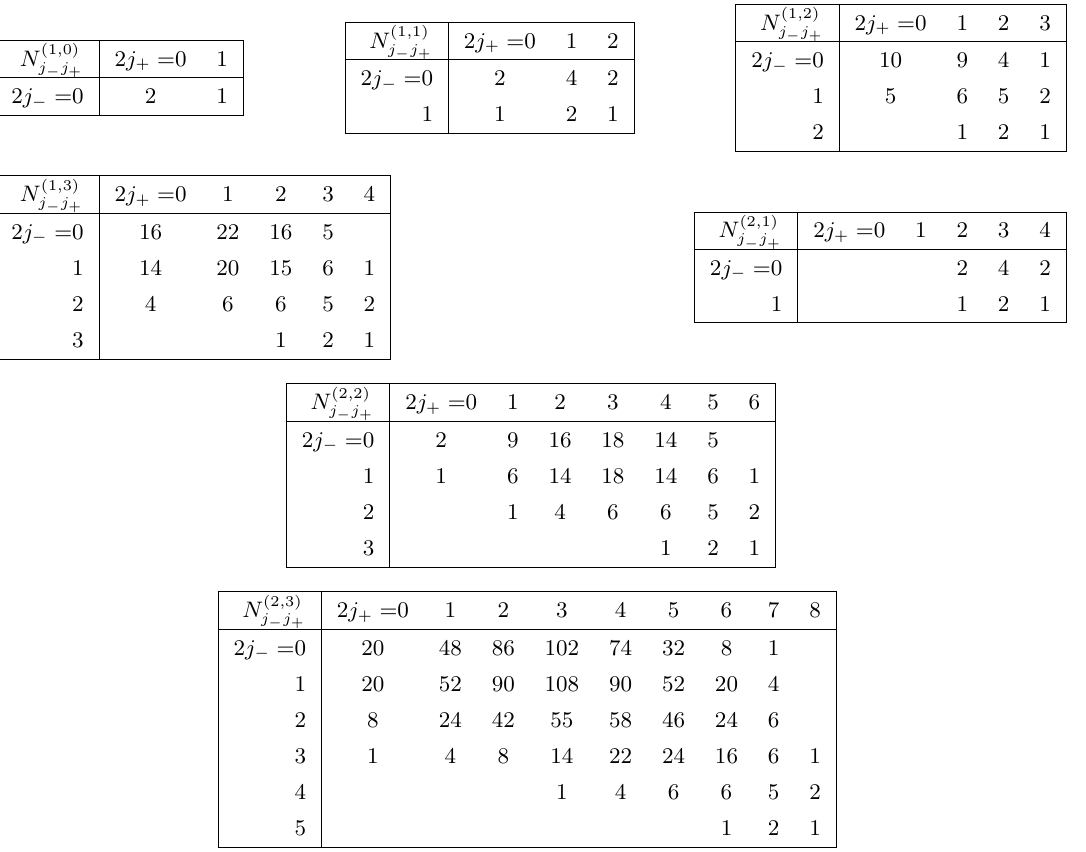
Table 6 . Refined BPS invariants of the massless M-string at base degrees b = 1 , 2 and e